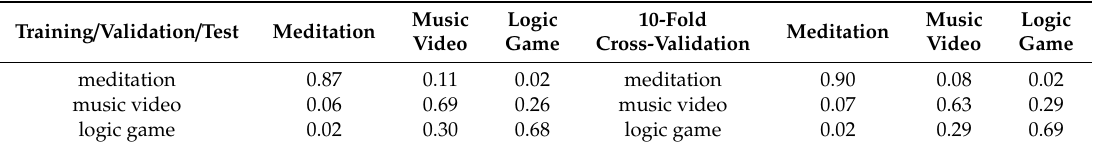
Table 25. Normalized confusion matrix for NN with three hidden layers, LeakyReLU activation function, and the welch32 feature extraction scheme (on the left side: training / validation / test scheme is shown, whether the outcomes of 10-fold cross-validation are contained on the right side).